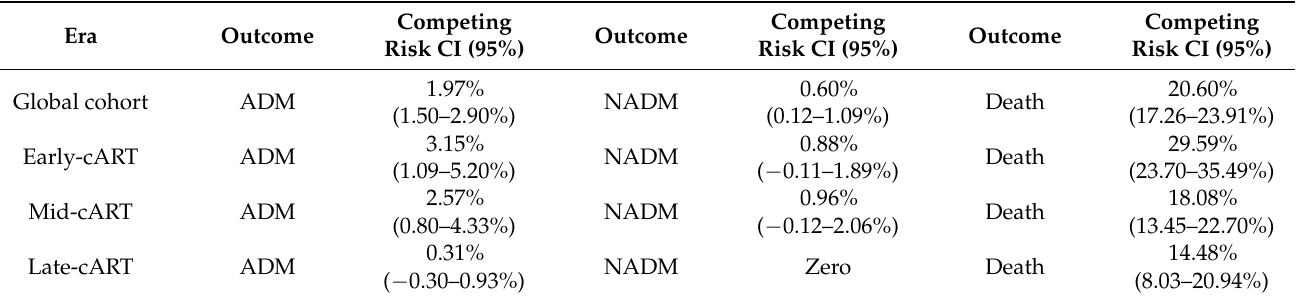
Figure 3. Cumulative Incidence (Competing Risk Model) for Death not related to Lymphoma or for ADM or NADM development in 30 years of evolution. Table 3. Competing Risk for Death not related to Lymphoma or for ADM or NADM development in 20 years of